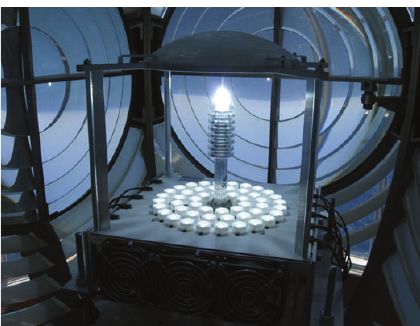
Figure 5: New source placed in the lighthouse, 3/4 view from above.